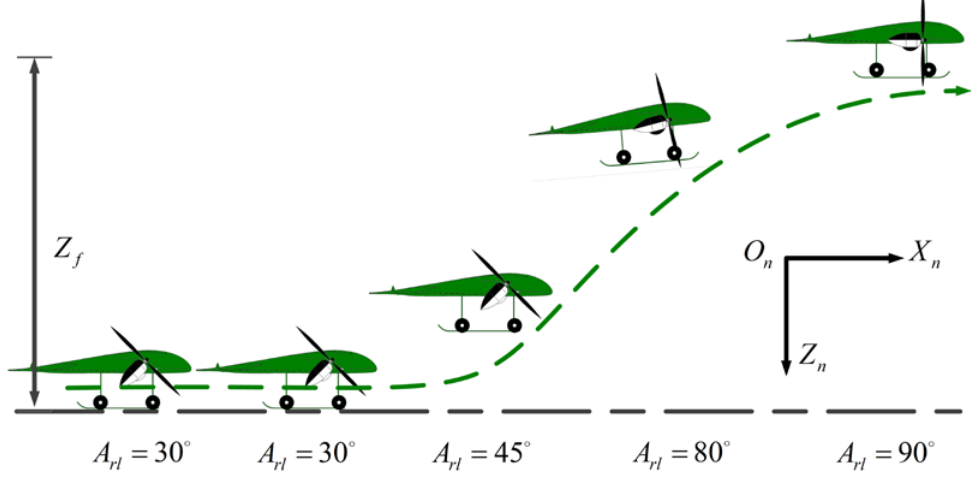
Figure 9. The flight path of STO scheme.